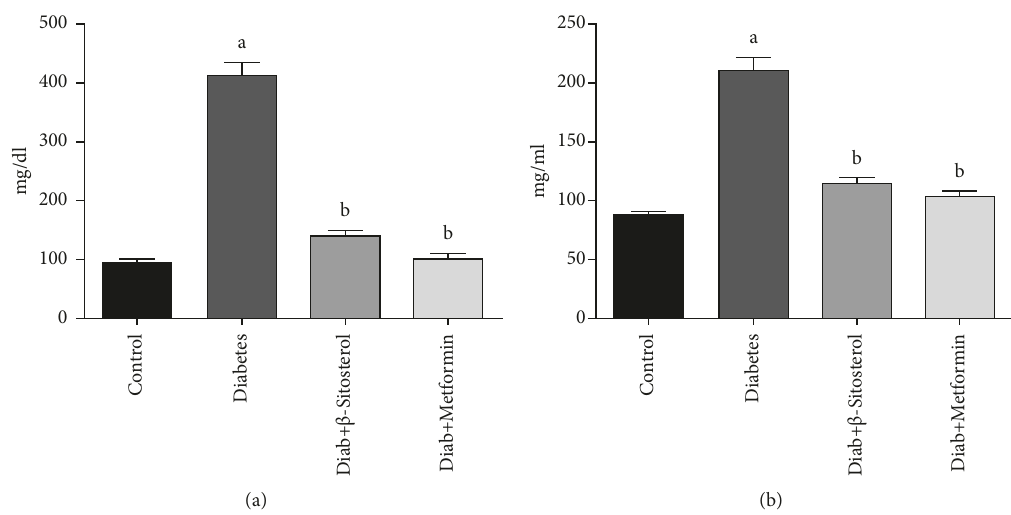
Figure 3: (a and b): Effect of β -sitosterol on (a) total cholesterol and (b) triglycerides levels in HFD and sucrose-induced diabetic male rats. Each bar signifies the mean ± SEM of 6 animals. Values significant at p < 0 . 05 were analyzed with a—control and b—diabetic control.